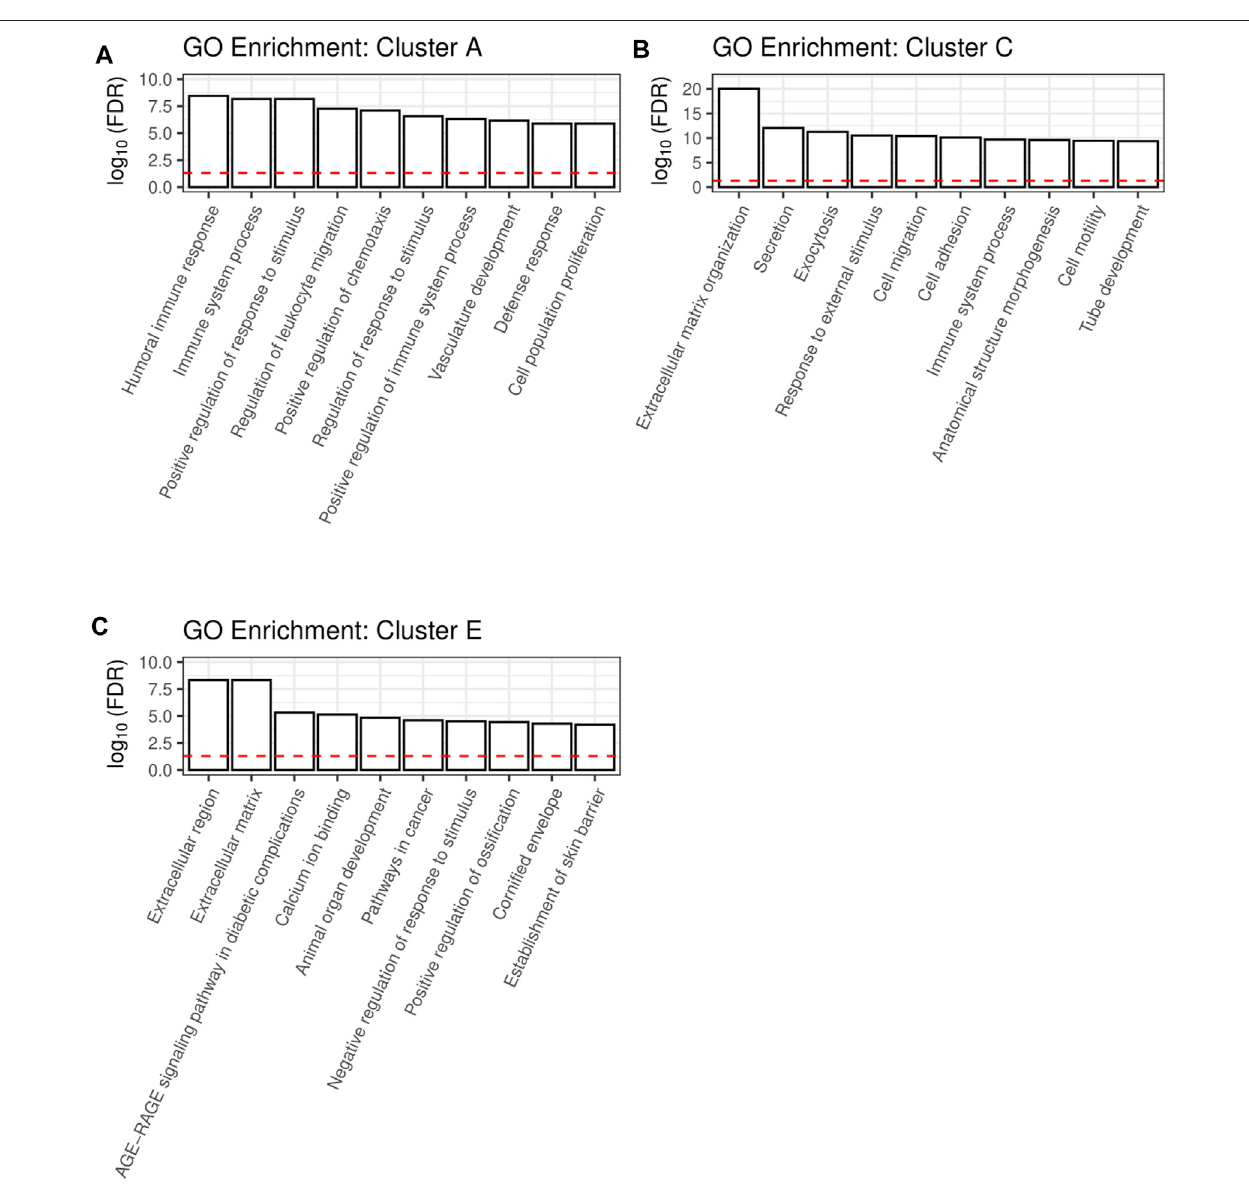
FIGURE 3 | A shiny GO enrichment analysis for the previously de fi ned cluster A (A) , cluster C (B) and cluster E (C) was performed. Redundant pathways were reduced to show only one representative pathway. Depicted is the − log10(FDR) of the top 10 pathways for each cluster. The red dashed line indicates the signi fi cance